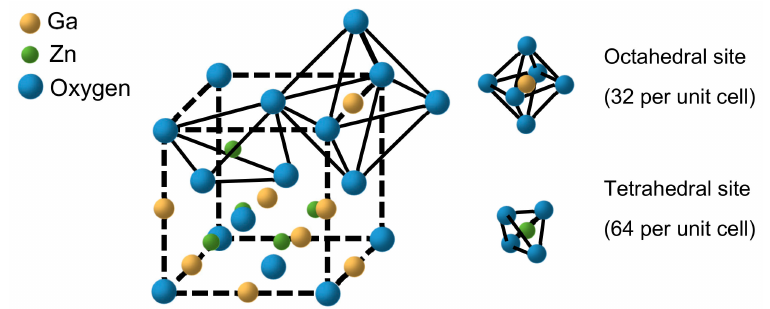
Figure 1. Spinel structure of ZnGa 2 O 4